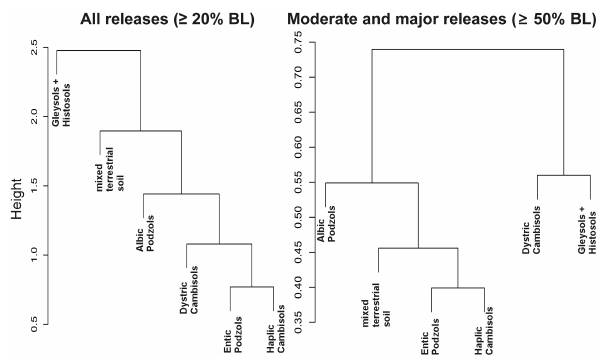
Figure 5. Statistical similarities of individual soil taxonomical units with respect to their disturbance histories. Cluster analyses were calculated separately for all releases ≥ 20% BL (left) and only stronger releases ≥ 50% BL (right). Heights refer to Euclidian dis- tances between STUs; for details see Sect.